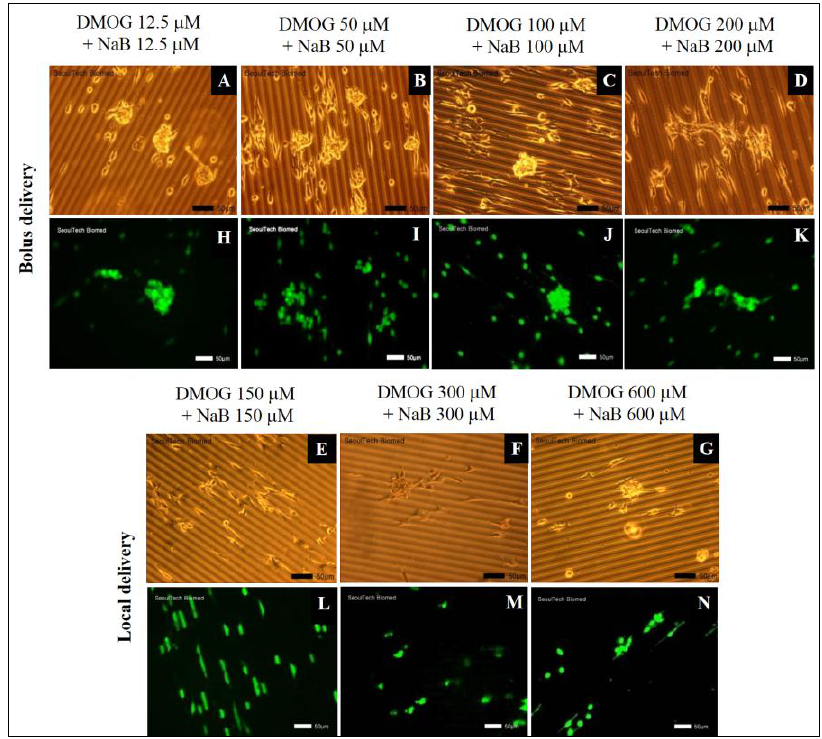
Figure 9. Cellular behavior of MC3T3 cells on the surface of HA-BDDGE patterned gel in presence of both DMOG and NaB after 7 days: bolus delivery ( A , H ) NaB/DMOG 12. 5 µ M, ( B , I ) NaB/DMOG 50 µ M, ( C , J ) NaB/DMOG 100 µ M, ( D , K ) NaB/DMOG 200 µ M, and local delivery ( E , L ) NaB/DMOG 150 µ M, ( F , M ) NaB/DMOG 300 µ M, ( G , N ) NaB/DMOG 600 µ M.